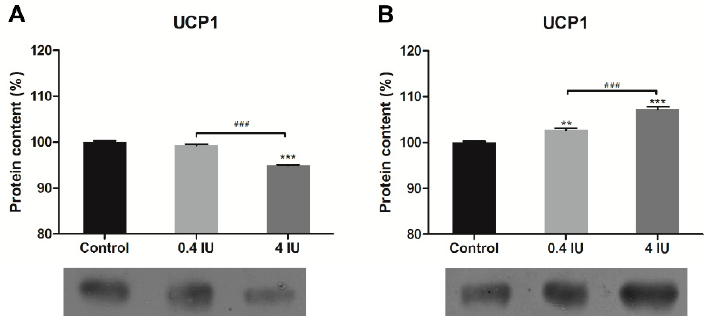
Figure 4. Effects of acute ( A ) and chronic ( B ) insulin treatment on the expression of uncoupling protein (UCP) 1 in MEF. Protein content is expressed relative to controls, which were standardized to 100%. Mean ± SEM values are averages of three independent experiments performed in triplicate (pooled from six animals in each group). A representative blot is shown. Volume is the sum of all pixel intensities within a band (1 pixel = 0.007744 mm 2 ). * compared to control: ** p ≤ 0.01, *** p ≤ 0.001; # 0.4 IU vs. 4 IU: ### p ≤ 0.001.